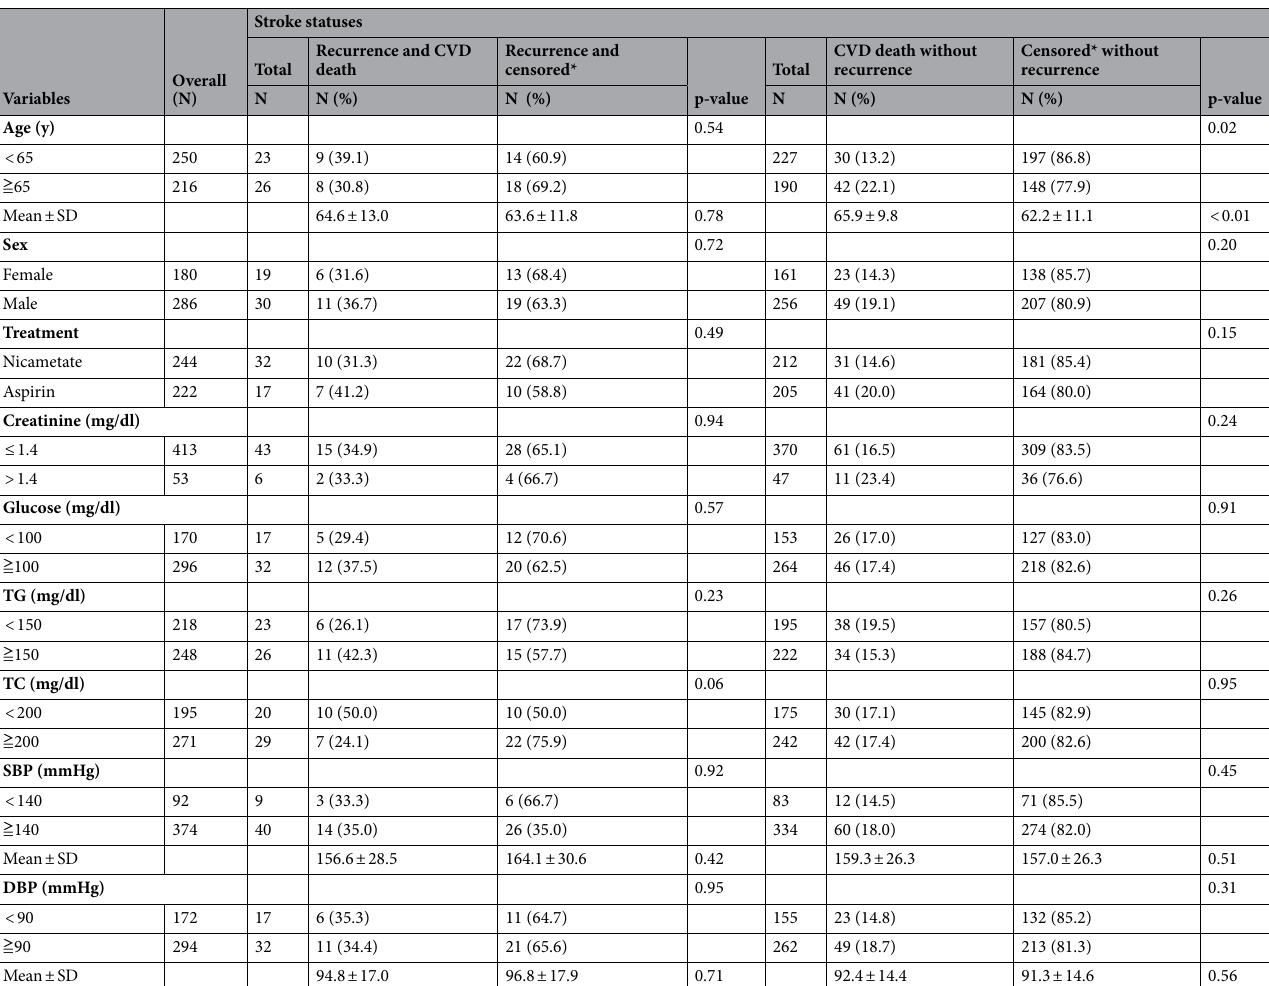
Table 1. Baseline characteristics of patients based on stroke statuses. CVD cerebrovascular disease, TG triglyceride, TC total cholesterol, SBP systolic blood pressure, DBP diastolic blood pressure. *Non- cerebrovascular death is described as censored